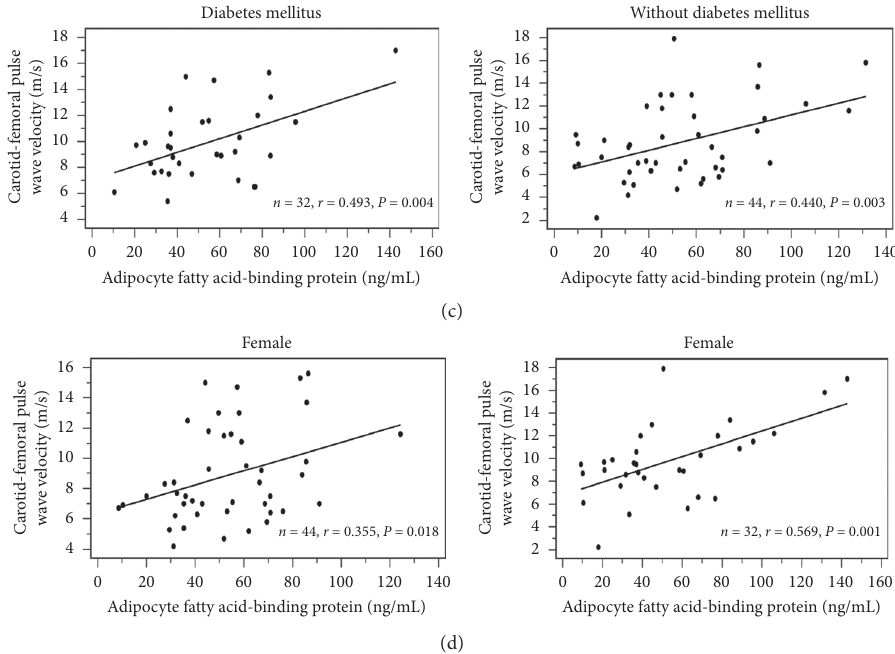
Figure 2: The scatter plot of A-FABP levels and cfPWV values in subgroup analysis with (a) older age, (b) hypertension, (c) DM, and (d)